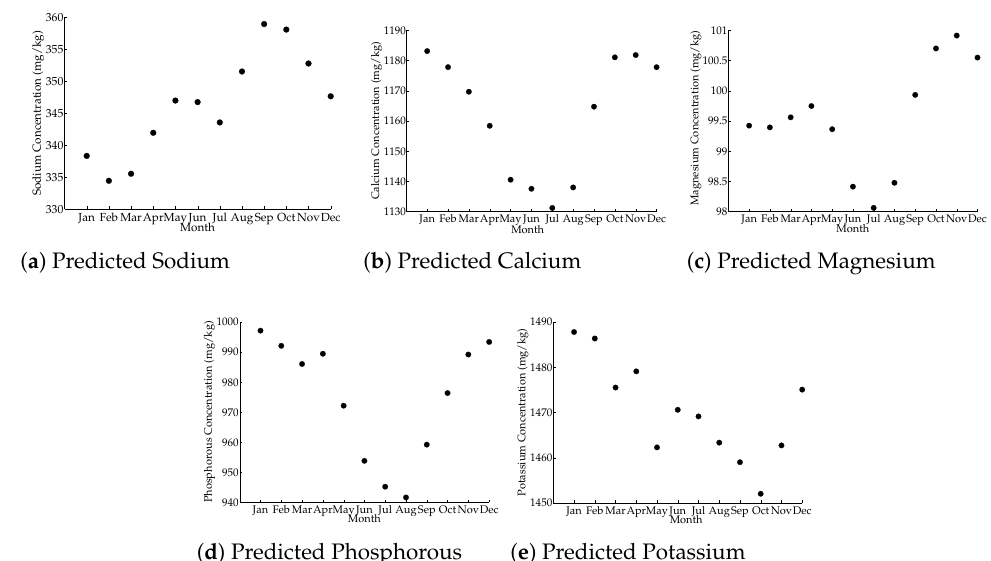
Figure 1. Evolution of predicted minerals in the function of the month when models are applied on a DHI milk spectral database. With a number of observations per month of: January ( n = 330,321); February ( n = 318,414); March ( n = 318,433); April ( n = 310,021); May ( n = 314,933); June ( n = 302,846); July ( n = 139,963); August ( n = 293,711); September ( n = 290,688); October ( n = 291,484); November ( n = 298,209); December ( n = 301,054). ( a ) Predicted Sodium ( b ) Predicted Calcium ( c ) Predicted Magnesium ( d ) Predicted Phosphorous ( e ) Predicted